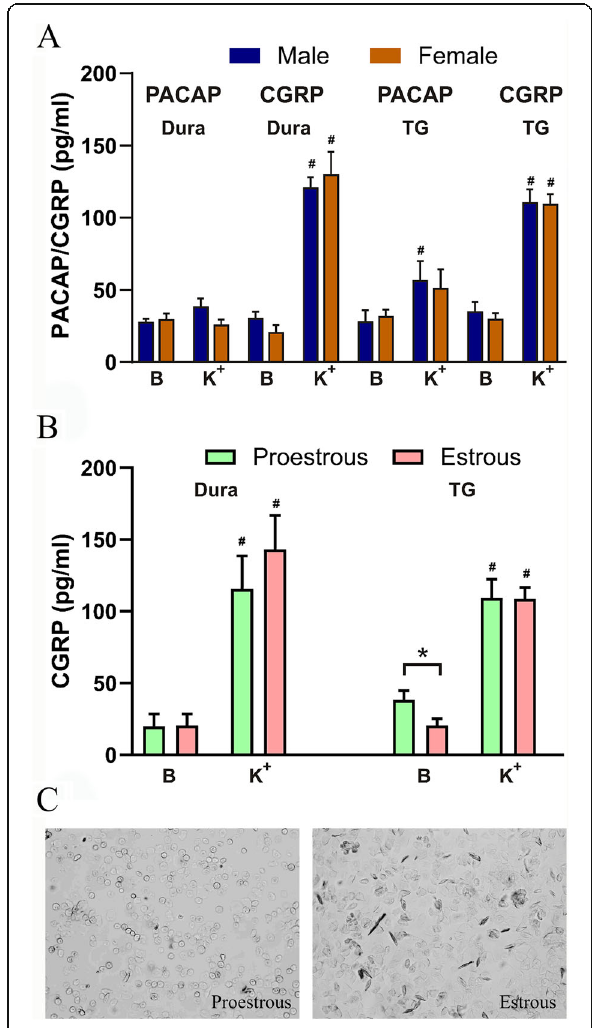
Fig. 11 Comparison of in situ CGRP and PACAP release from the dura and trigeminal ganglion. a The addition of 60 mM KCl (K+) caused no PACAP release from the dura but a significant release was seen from the TG in males ( n = 12) but not in females ( N = 10). CGRP release was much stronger both from the dura and the TG. b there were no significant differences in the CGRP releases in the dura or TG, however a significant lower baseline was observed in females in estrous. c Representative samples of the vaginal smears from the female rats, used to determine the cycle-stage. Data are shown as mean ± SEM or their individual data points with pairing, and with p values obtained with Student ’ s T-test being depicted in the graph. * = p < 0.05 between groups, and # = p < 0.05 from